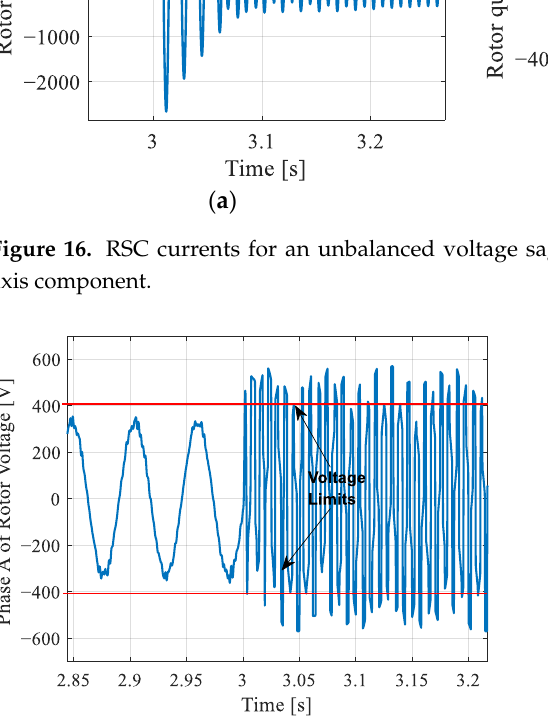
Figure 17. Rotor voltage in phase A for an unbalanced voltage sag of 20%.